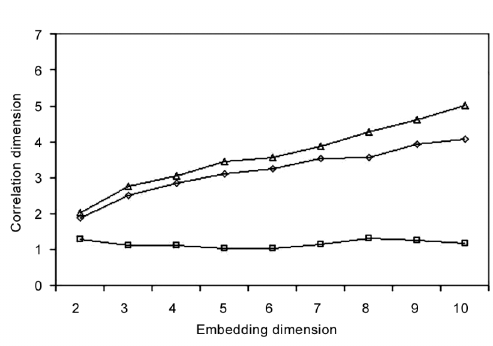
Fig. 4. Correlation dimension versus embedding dimension of waiting times sequences (complete cat- alogue) after noise reduction: diamonds – before ex- periments; squares – during experiments; triangles – after experiments.